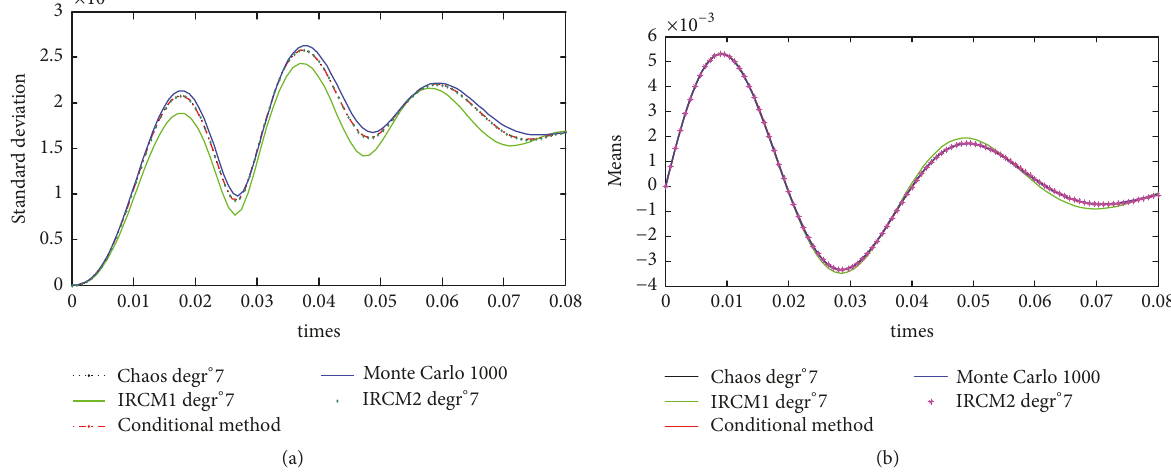
Figure 3: (a) Standard deviation of 𝑈 when 𝜉 𝑖 follow the uniform law in [−4, 4] and 𝜎 𝑖 = 20%. (b) Means of 𝑈 when 𝜉 𝑖 follow the uniform law in [−4,4] and 𝜎 𝑖 = 20%.